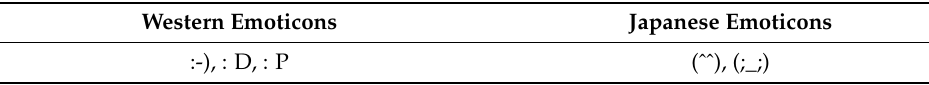
Table 1. Examples of emoticons (Western vs. Japanese).